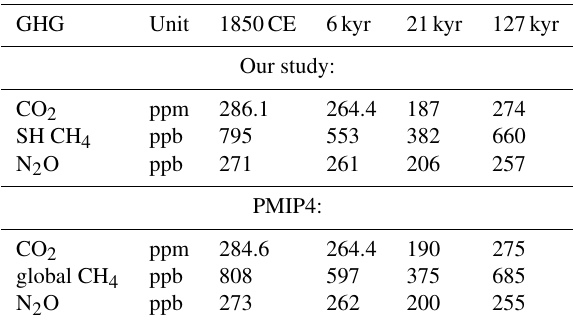
Table 4. Comparison of our final spline data with values used for PMIP4 experiments for 21kyr (Ivanovic et al., 2016) and 1850CE, 6kyr, and 127kyr (Otto-Bliesner et al., 2016). Please note that the PMIP4 values should be millennial-scale mean numbers to serve as forcing values for time slice experiments, while the values given from our study are snapshots of the given points in time. Further- more, we calculate SH CH 4 values, while in PMIP4 the global CH 4 is